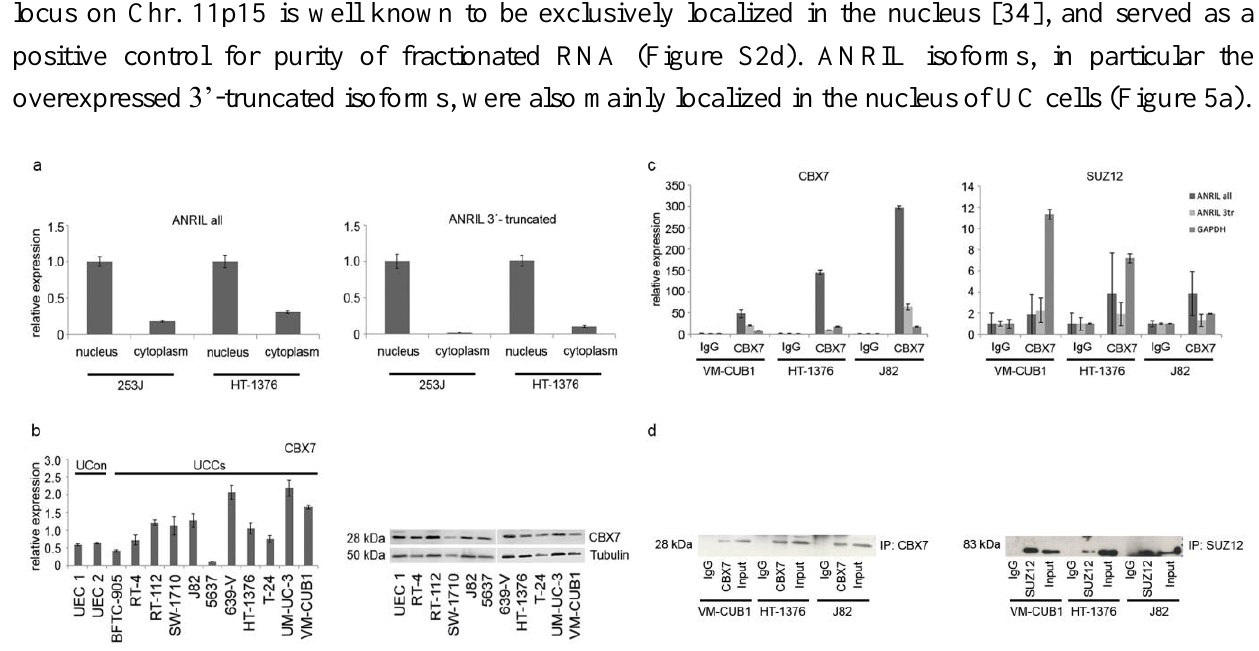
Figure 5. ( a ) ANRIL was mainly localized in the nucleus of UCCs as determined by qRT- PCR for all transcripts (left panel) and overexpressed 3’-truncated variants in particular (right panel) subsequent to fractionated extraction of RNA. Purity of nuclear fractions was checked by measuring the antisense transcript LIT1 as a control (Figure S2d). ( b ) Abundance of the interaction partner CBX7 in UCCs was checked on the RNA (left panel) and protein level (right panel). ( c , d ) Direct interaction between lncRNA ANRIL and PcG proteins was determined by RNA immunoprecipitation (RIP) analysis. Although both proteins were sufficiently precipitated ( d ), only interaction of ANRIL with CBX7 was detectable by qRT- PCR (( c ), left panel), but not with SUZ12 above background levels ( c , right panel). Results from IgG isotype controls were set as 1. GAPDH served as another background control. Both full length (included in “all” assay, dark grey bar) and 3’-truncated ANRIL isoforms (light grey bar) interacted with CBX7